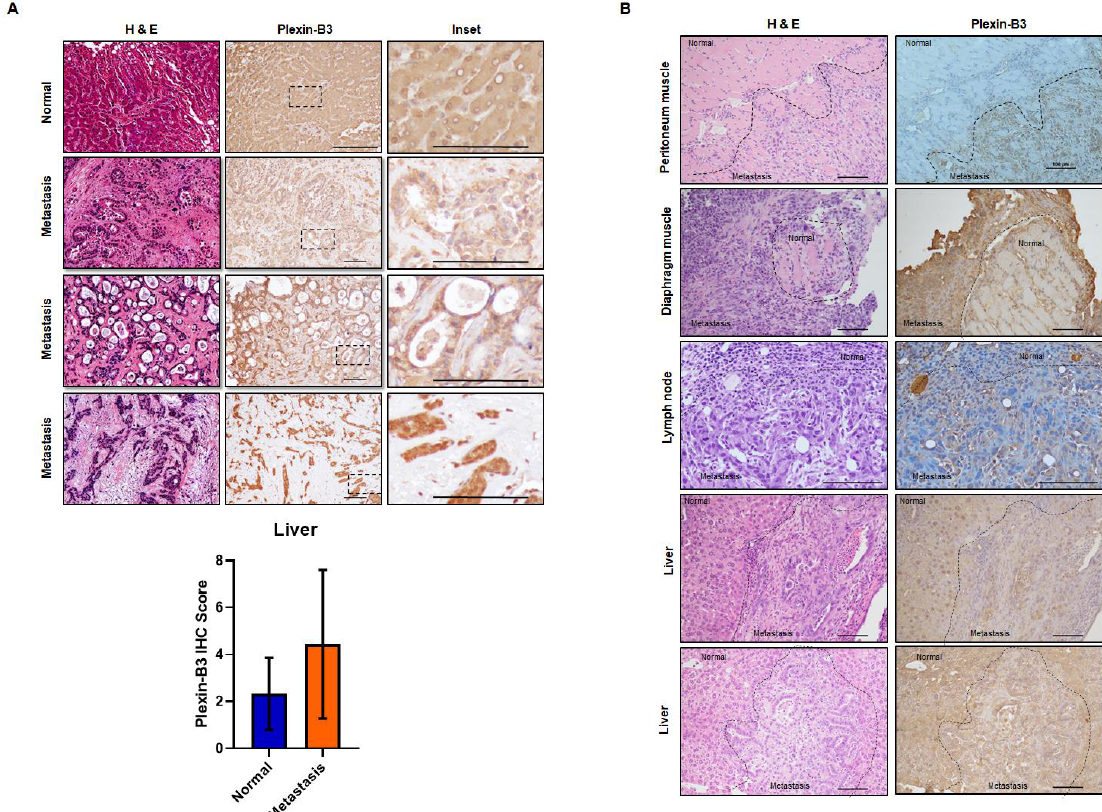
Figure 2. Pathological expression of Plexin-B3 in the metastatic sites of PC. ( A ) Representative images of Plexin-B3 IHC, along with the corresponding H&E of human normal liver and liver metastatic cores present in the tissue microarray. The normal liver is positive for the expression of Plexin-B3. The scale bar represents 100 µ m. Bar graph showing higher Plexin-B3 IHC scores in metastatic lesions in comparison with normal liver tissue. ( B ) Representative images of Plexin-B3 IHC performed on different metastatic sites (lymph node ( n = 1), liver ( n = 5), diaphragm muscle ( n = 1), and peritoneum muscle ( n = 2)) derived from the progression model of Kras G12D ; Trp53 R172H ; Pdx1-Cre (KPC) mice. The scale bar represents 100 µ